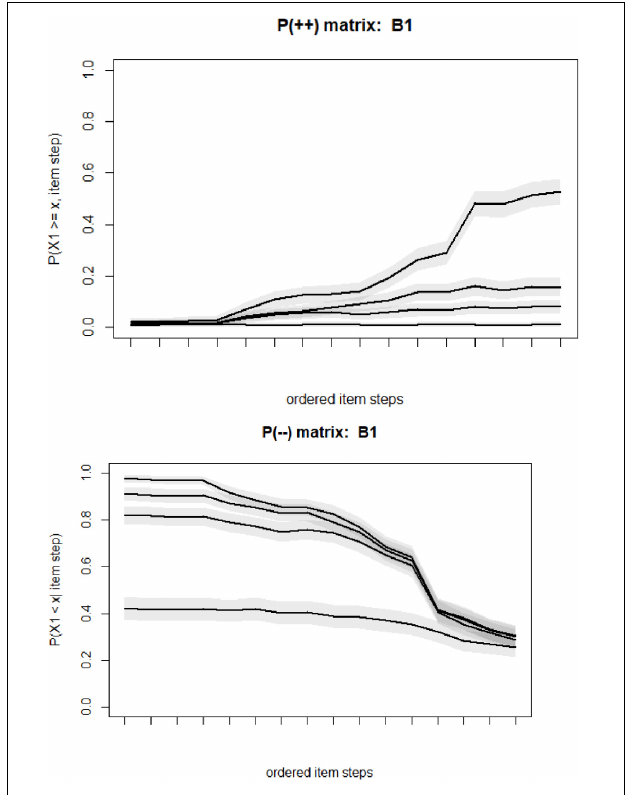
FIGURE 2 | Results of non-intersecting diagnostic for item B1.